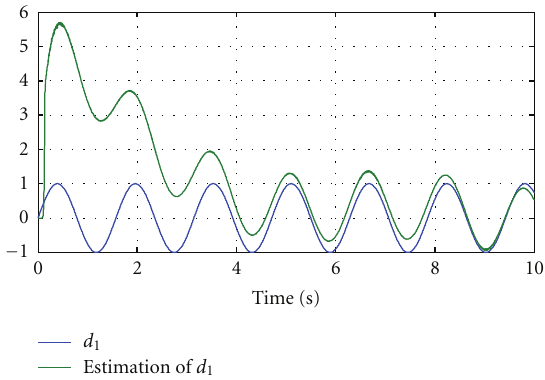
Figure 8: System inputs u 1 and u 2 for Example 6. Figure 9: True and estimation values of d